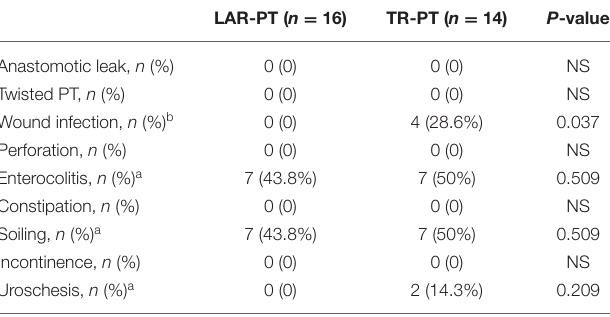
TABLE 2 | Early post-operative complications and short-term outcome.